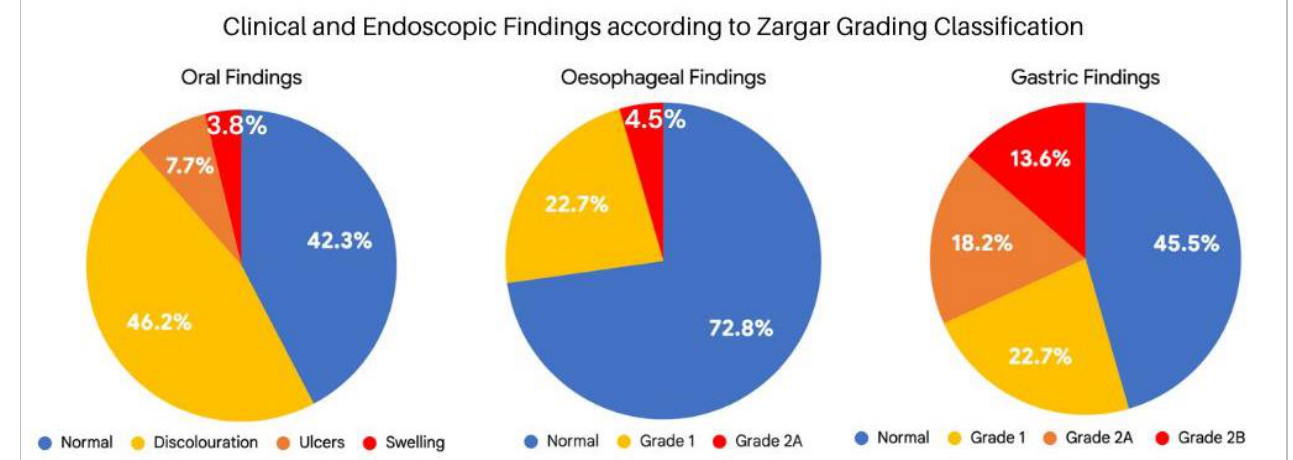
Figure 2. Clinical and Endoscopic